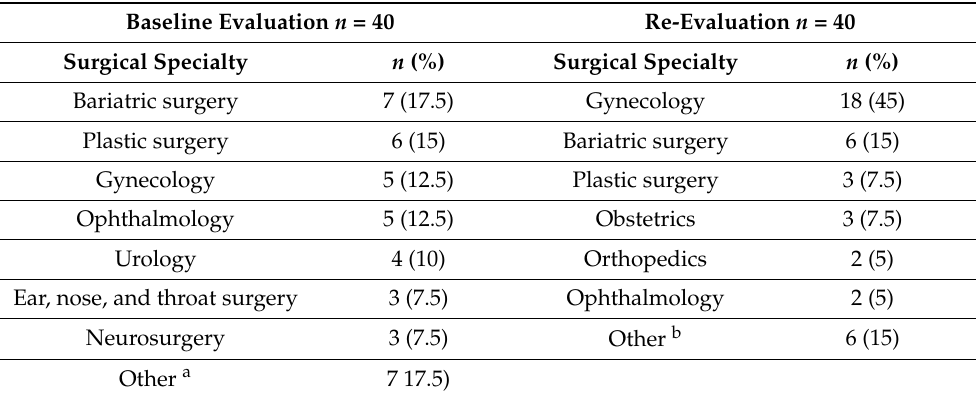
Table 2. Surgical specialties involved in the care of patients at baseline ( n = 40) and re-evaluation ( n = 40).